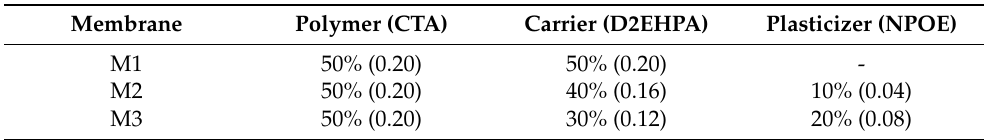
Table 1. Composition of the PIMs studied in this work expressed in % mass. The amount of each component (g) is indicated in parentheses.